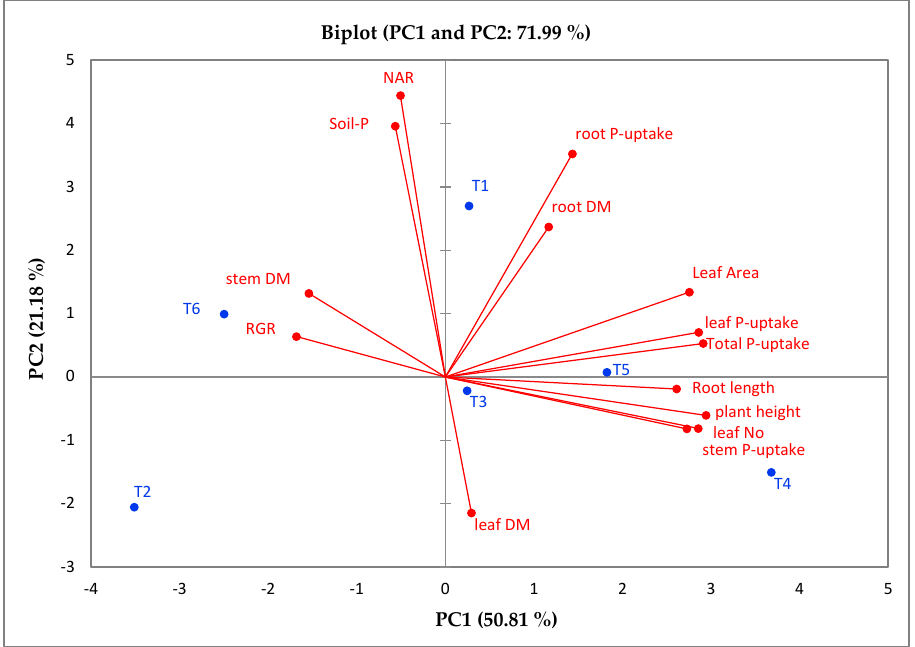
Figure 6. Biplot of PCAs describing the correlation between the evaluated traits in response to four treatments. PGPB in presence of either rock phosphate or mono-super phosphate.